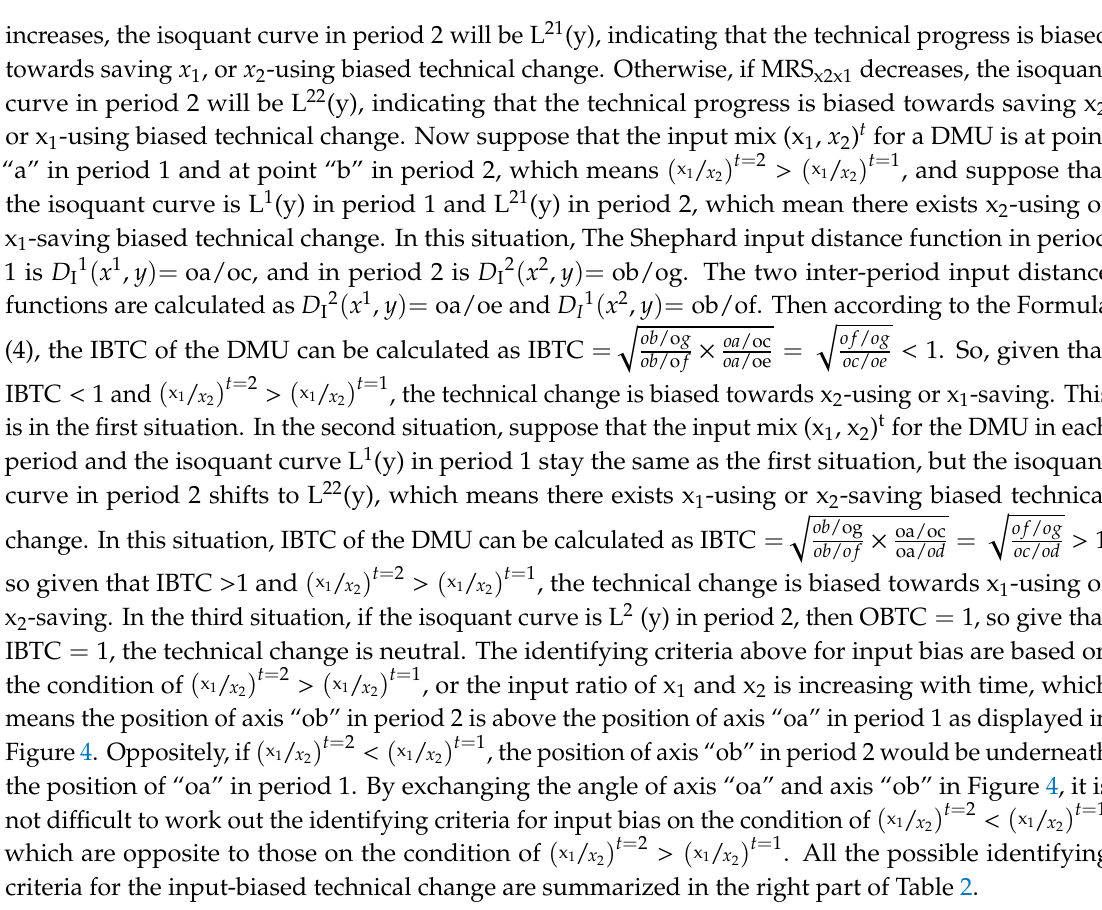
Figure 4. Oppositely, if ( x 1 / x the position of “oa” in period 1. By exchanging the angle of axis “oa” and axis “ob” in Figure 4, it is not di ffi cult to work out the identifying criteria for input bias on the condition of ( x 1 / x which are opposite to those on the condition of ( x 1 / x